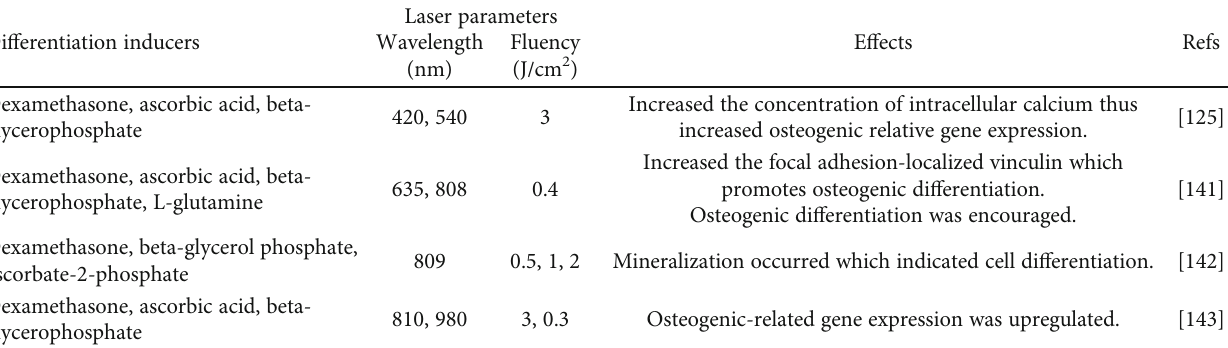
Table 4: The combined e ff ects of using PBM and di ff erentiation inducers for MSCs into